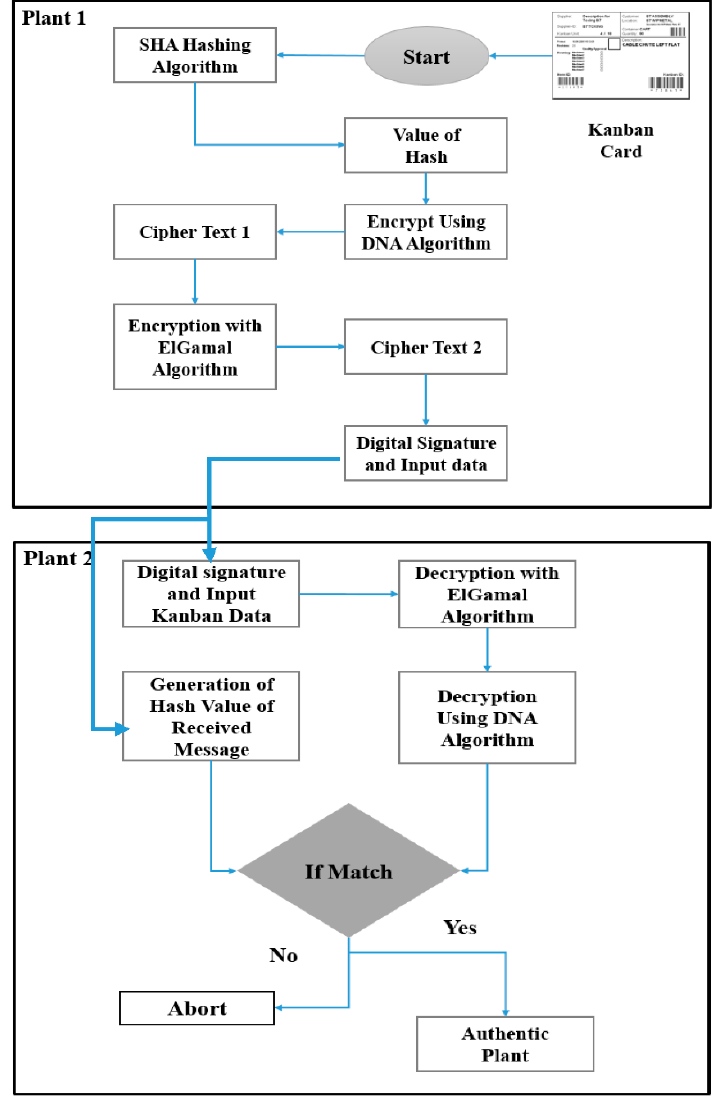
Figure 4. Flowchart of Proposed Algorithm for security system.